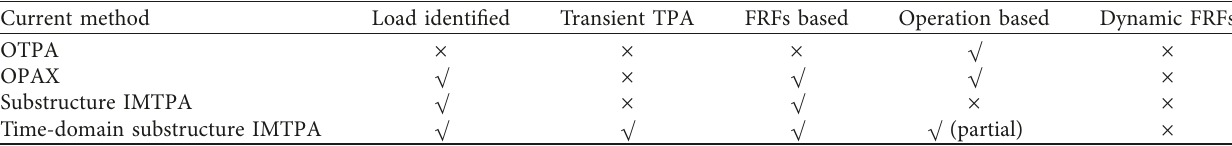
Table 1: Comparison of TPA methods.